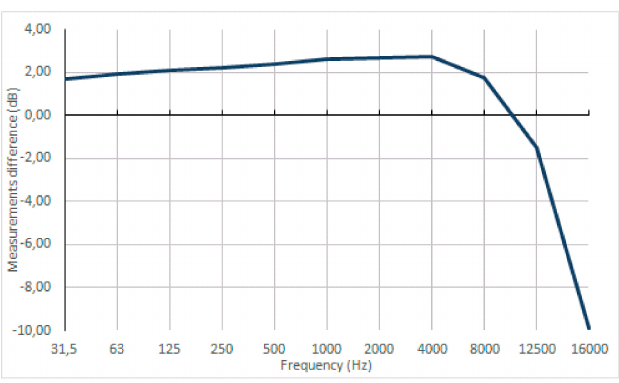
Figure 8. Tests results using a multifrequency calibrator.